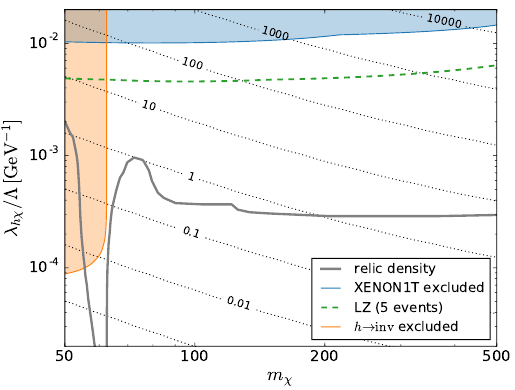
Figure 9 . Constraints and preferred parameter regions for the CP-violating Higgs portal model with (cid:30) = (cid:25)= 2. The dotted lines indicate the ratio of loop-induced spin-independent interactions and tree-level momentum-suppressed interactions in terms of the predicted number of events in